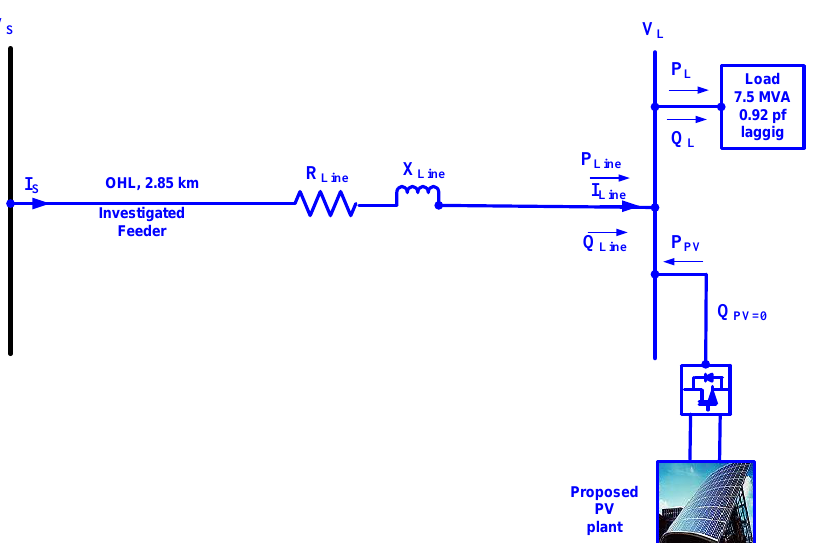
Figure 3. Single line diagram of Overhead Lines (OHL) with proposed photovoltaic (PV)